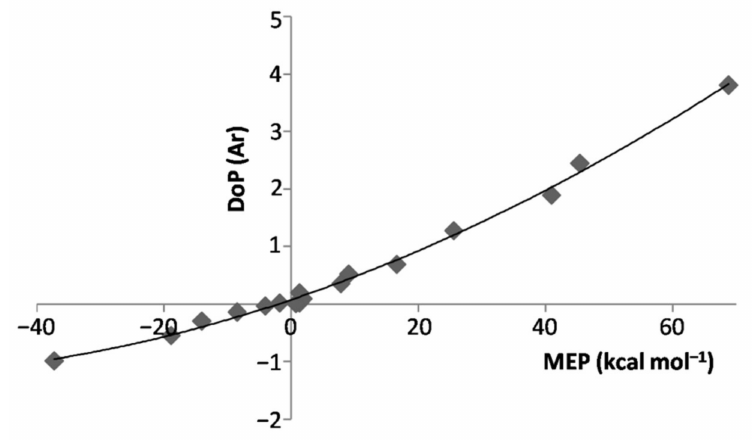
Figure 3. DoP(Ar) of the L Ar vs. MEP at the V S,max / V S,min of L .